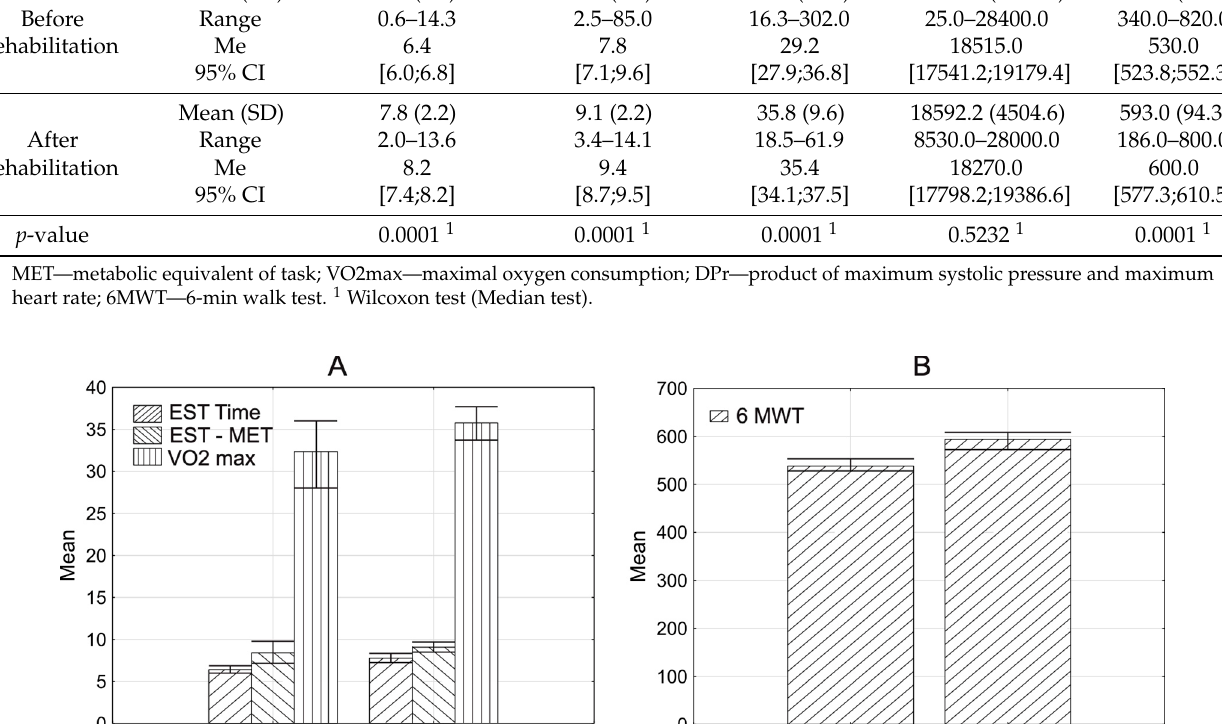
Figure 3. Characteristics of examined group. Mean before and after rehabilitation in the 3rd phase of rehabilitation. ( A ) exercise stress test time (EST time), exercise stress test MET (EST MET), VO2max. ( B ) 6MWT; p < 0.05. Similar to the cardiac rehabilitation in the 3rd month, parameters presented in Table 4 increased significantly. Table 4. Comparative characteristics of the examined group in terms of: exercise stress test time, exercise stress test MET, VO2max, DPr, and 6-min test measured at baseline and after rehabilitation.